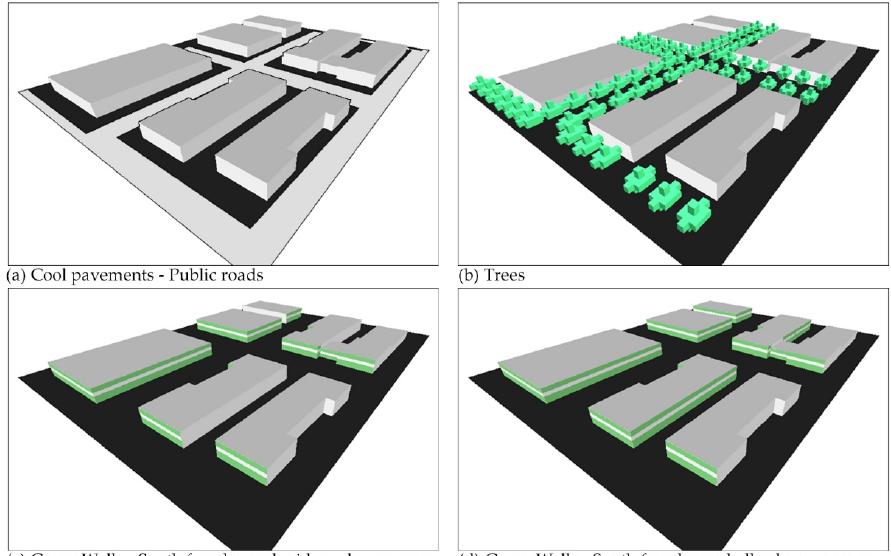
Figure 4. Different configurations of the green strategies applied to the portion of the industrial district (M2). In the Figure ( a ) is the configuration with cool pavements, ( b ) is the one with trees, ( c ) is the configuration with green walls on southern facades and wider urban canyons, ( d ) is the con- figuration with green walls for southern facades and all urban